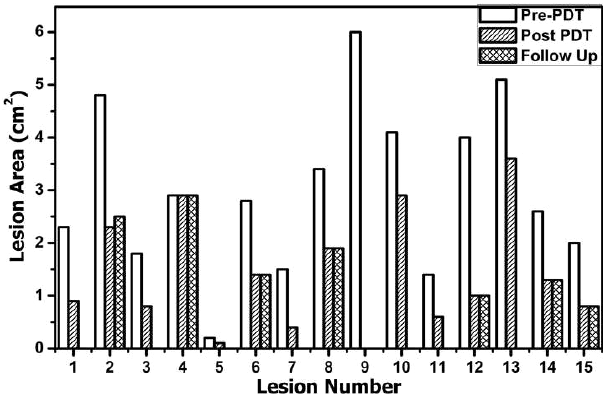
— Fig. 1. Size of the OLP lesion at pre-, post-PDT and follow-up